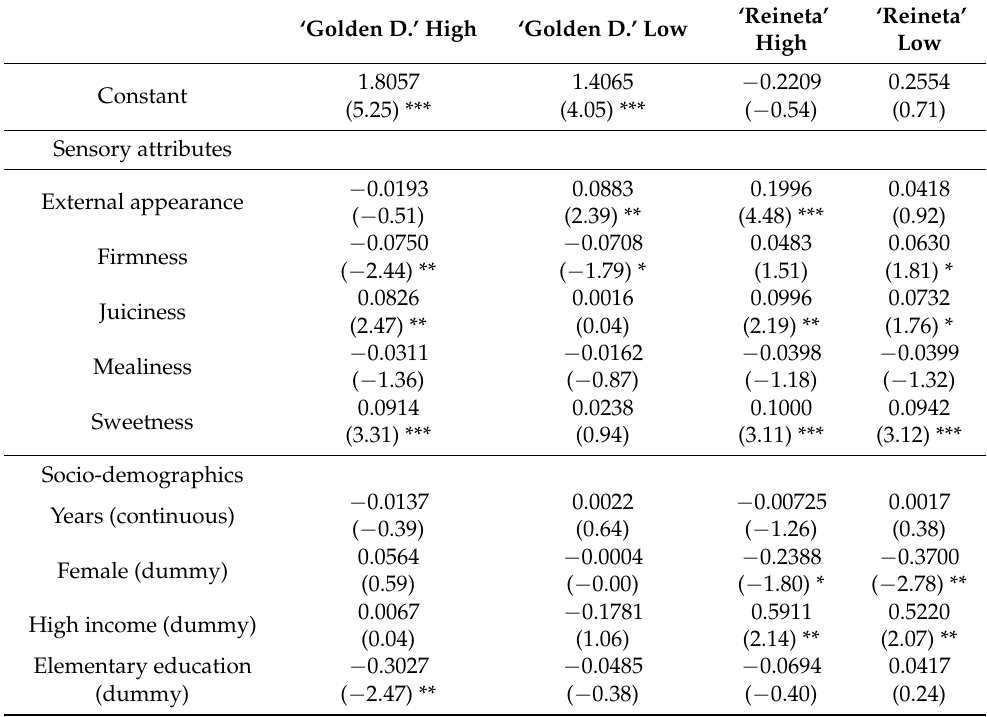
Table 4. Effects of sensory attributes scores and consumers’ socio-demographic characteristics in the WTP for the apples: estimations of the Tobit model. ‘Reineta’ ‘Golden D.’ High ‘Golden D.’ Low